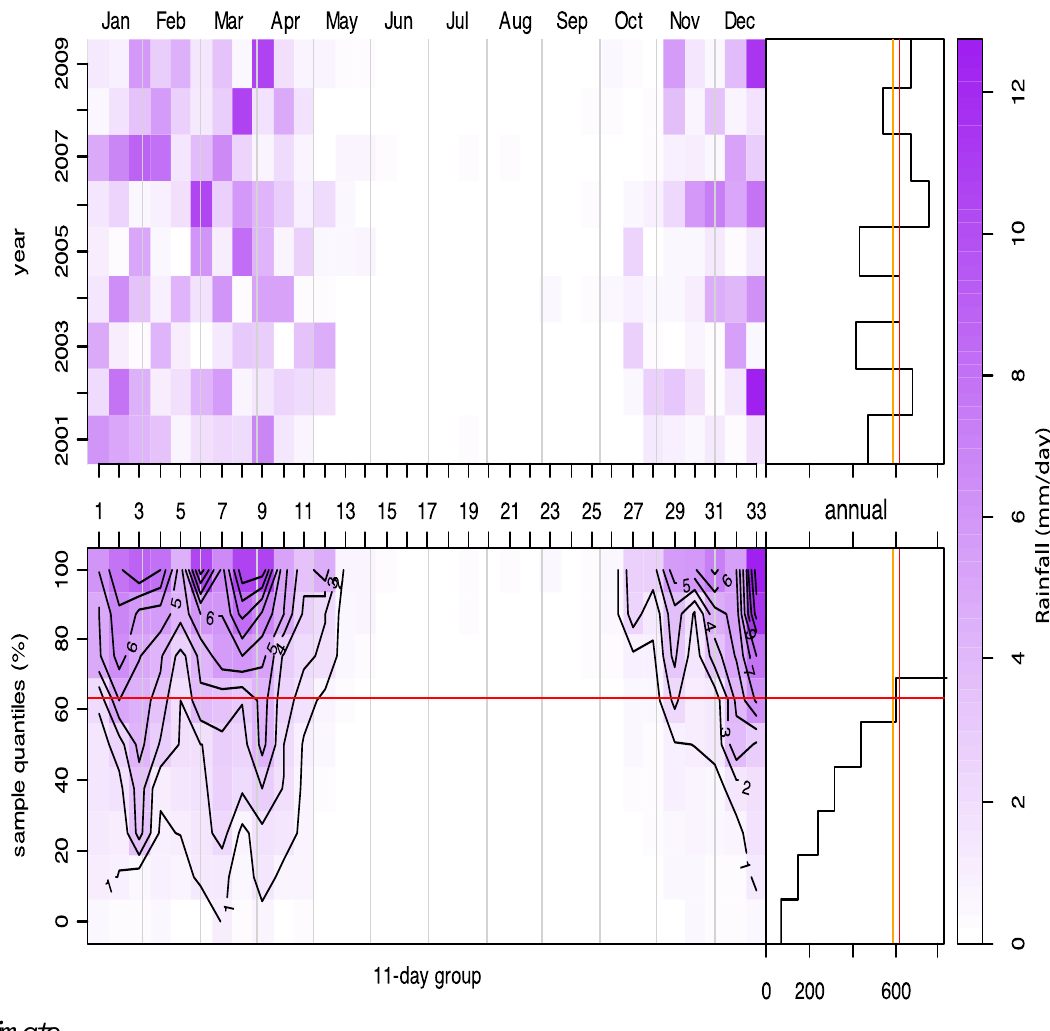
Figure 2. Lake Manyara seasonal rainfall pattern 1 January 2001, and 31 December 2009; created based on 11-day groups, starting in January. The upper-left frame is the normalized sum of daily precipitation rates for each case and annum pair, which sum row-wise to the upper-right frame to present annual precipitation totals; the lower-left frame is sorted vertically to represent the sample quantiles, and is contoured; the lower-right frame is the row-wise sum of sample quantiles; the vertical (red) line indicates the median of the annual sums, and the horizontal line represents the seasonal ‘normal’ that has the same annual